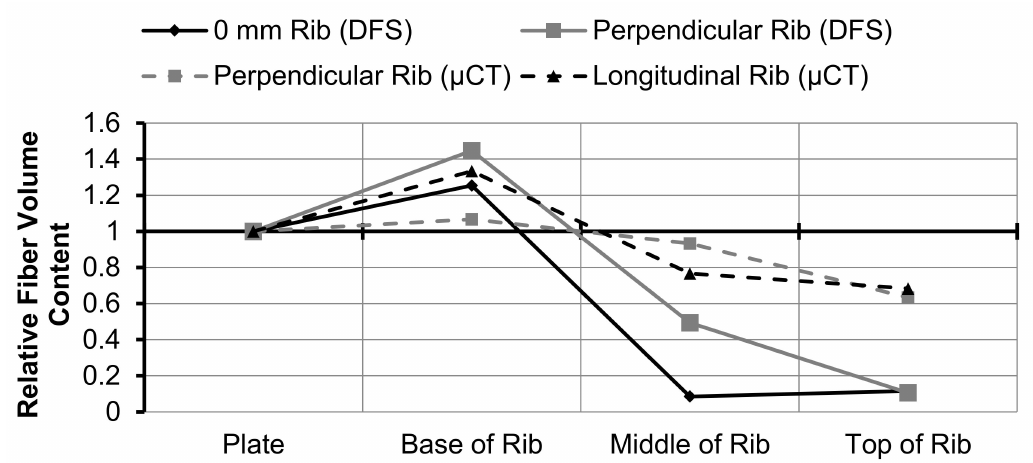
Figure 16. Comparison between fiber volume content taken from molded parts [15], and predicted values from the direct fiber simulation. Measured values are shown with dashed lines and simulation results with